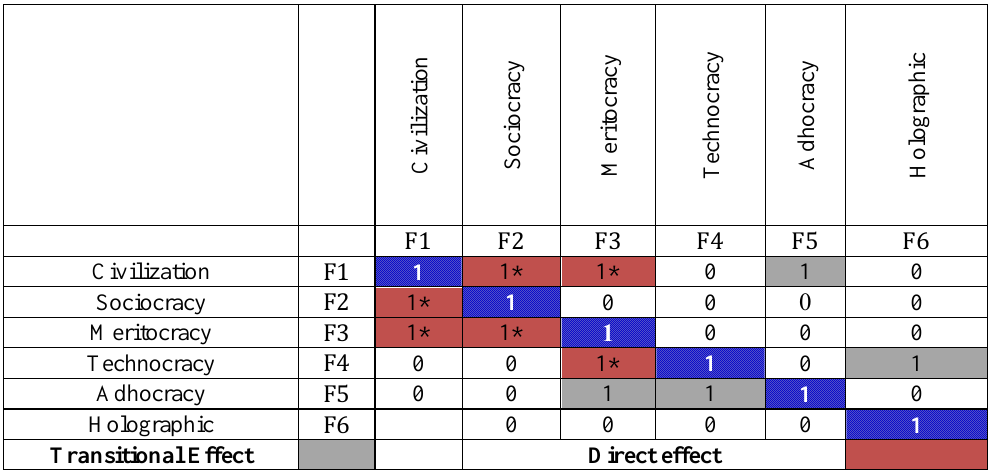
Table 12. Achievement Matrix Transitional Relations